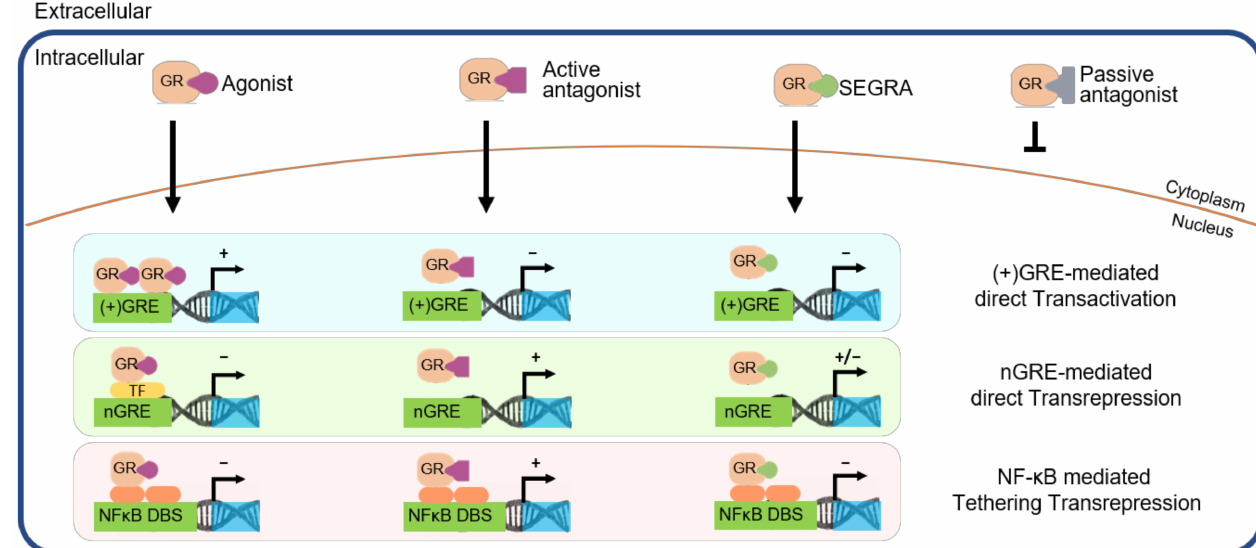
target genes. Plus (+) indicates stimulation of gene activation or repression, whereas minus ( − ) indicates no effect on stimulation or